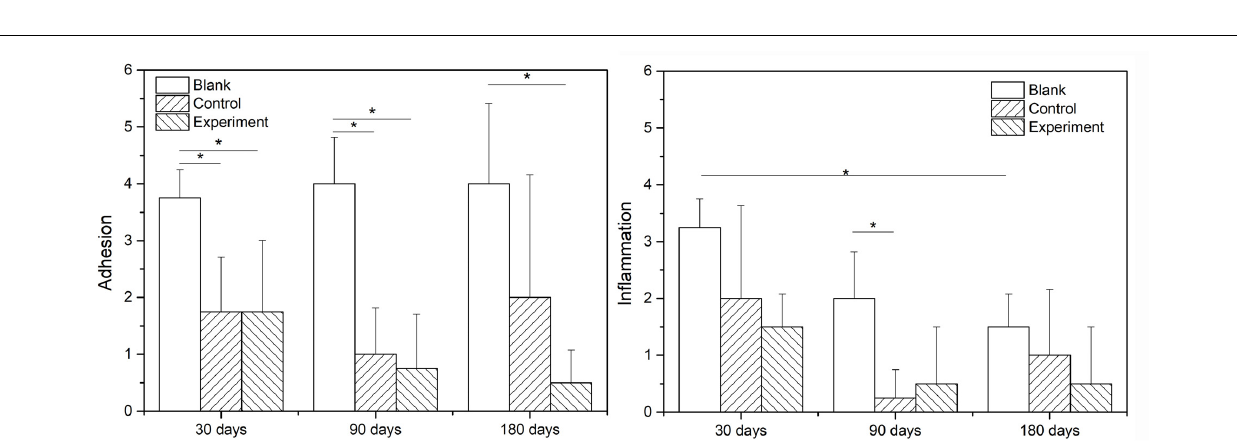
FIGURE 8 | The histological observation of the implants (A: brain tissue; the arrow → pointed to the repaired tissue; I: × 100, II: × 400).